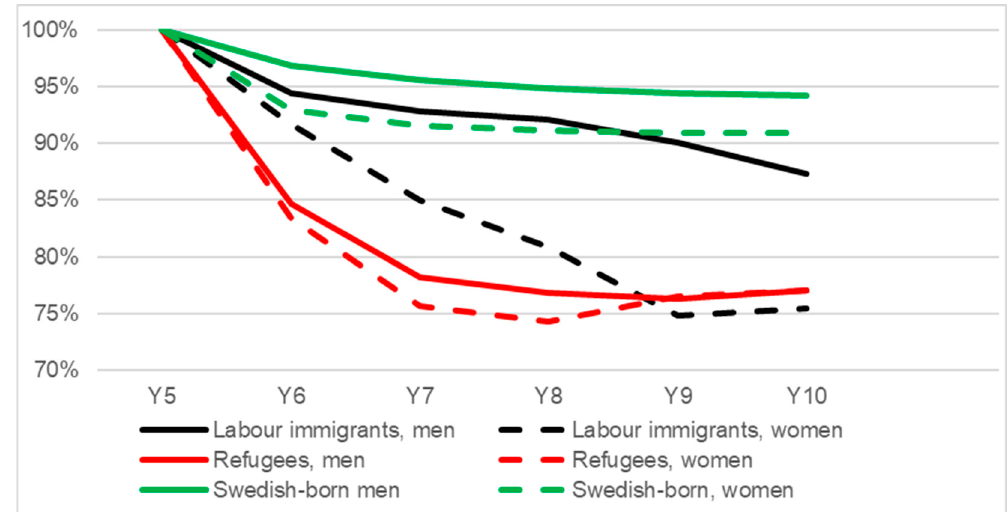
Figure 2. The proportion with an income of 1.75 PBA or more from paid work (self-sufficiency) at year 6–10 for the shares of labour immigrants, refugees and Swedish-born that earned 1.75 PBA 1 at year 5 after receiving a residence permit 2 (stratified by sex, n = 127 133). 1 Price base amount, an annual figure, e.g., benefits taking into account inflation; 2 Year of residence permit = year 0. Swedish-born were given a fictive “year 0” 2000–2006 and were matched by age and sex; approx. 5 Swedish-born to each immigrant.